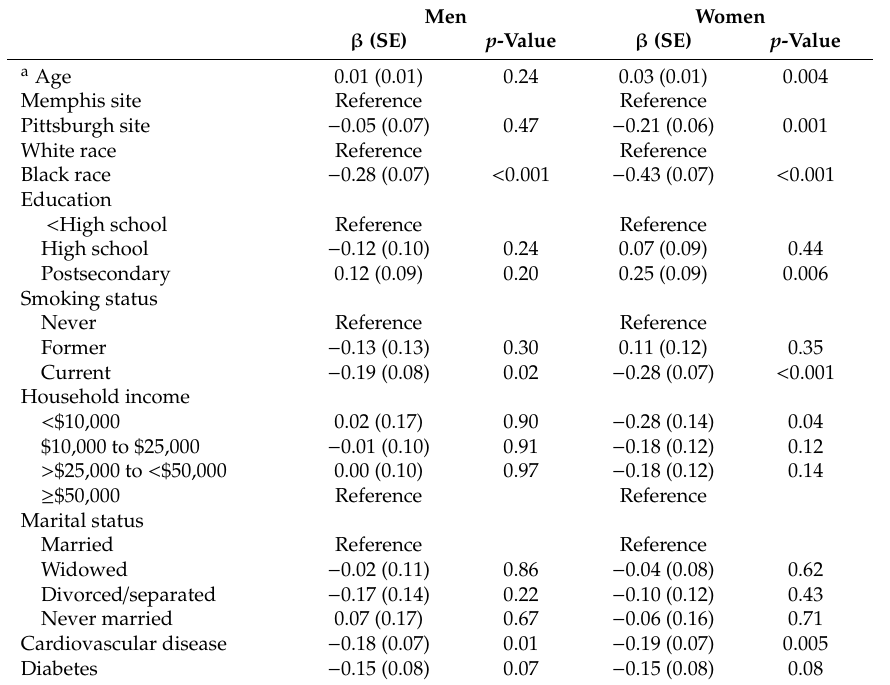
Table 4. Association between the composite cancer prevention score and characteristics in the Health ABC Study by